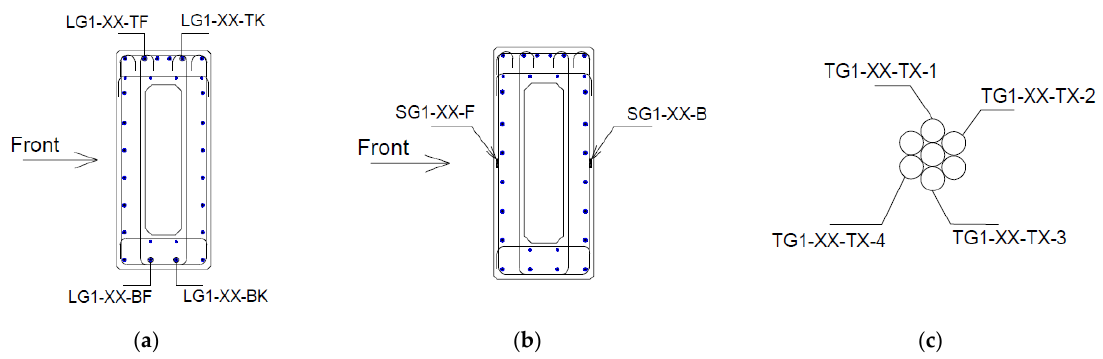
Figure 11. Details of strain gauges ( a ) LG1, ( b ) SG1, and ( c ) TG1.